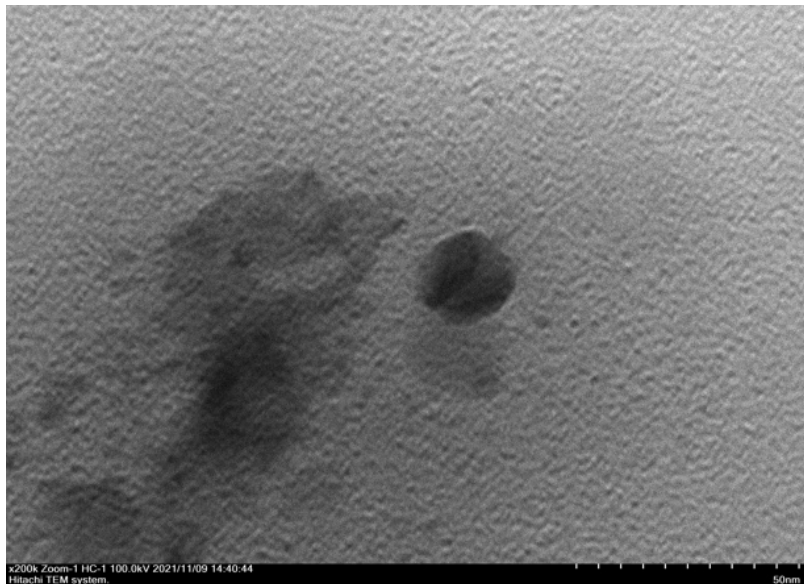
Figure 5. Micrograph of ( A ) purified catechin, ( B ) empty transethosome ( C ) transethosomal catechin in 400× magnification.